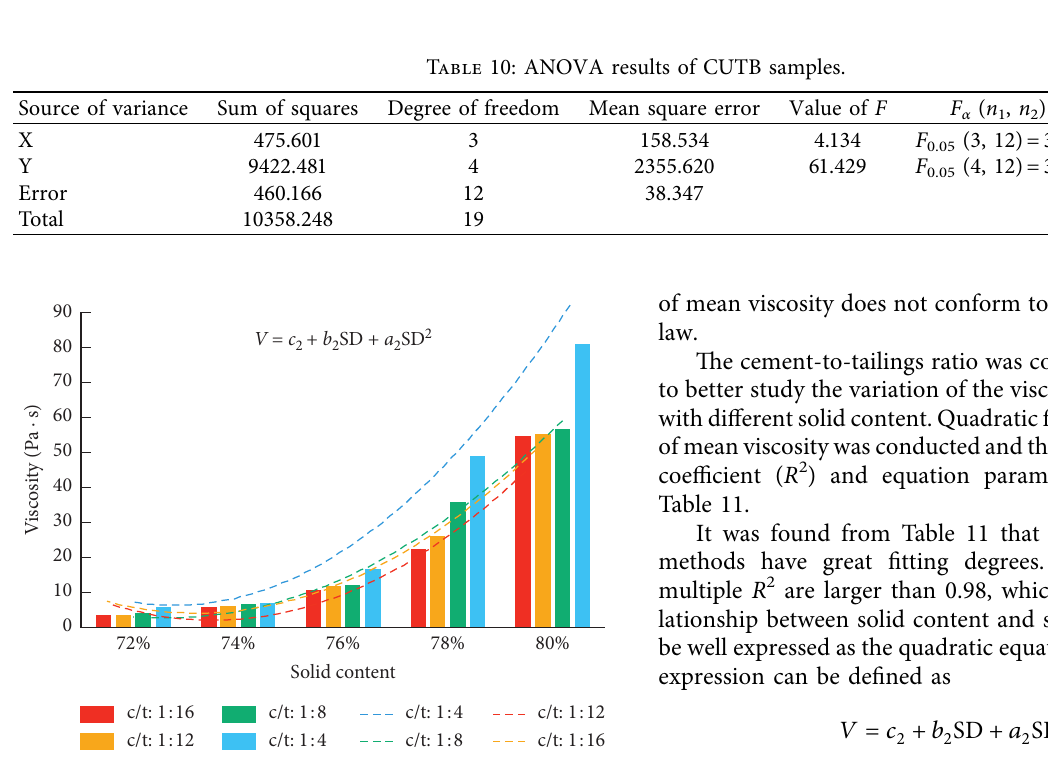
Figure 5: Histogram between SD and viscosity of CUTB samples.